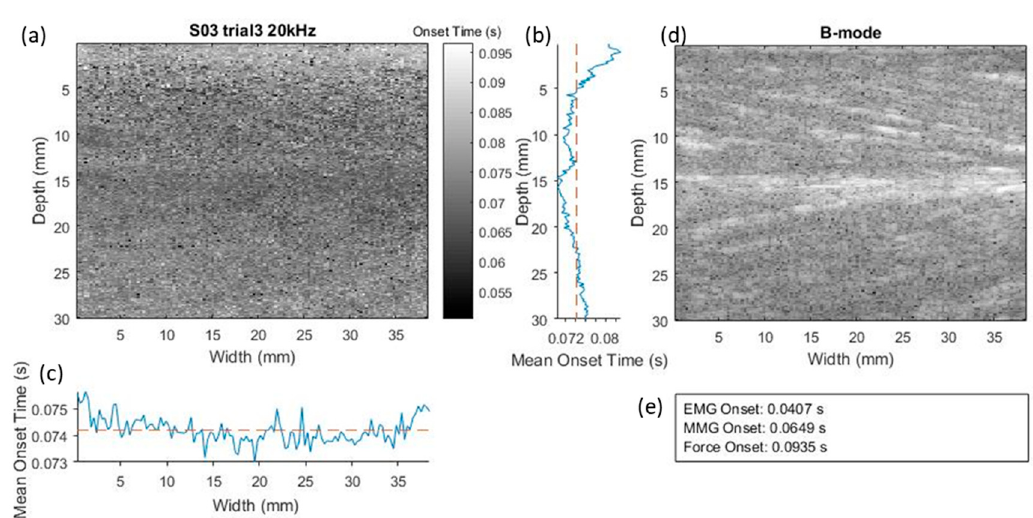
Figure 3. As example illustrating the ultrasound SMMG onset map ( a ), B-mode ultrasound image of muscle along longitudinal view ( d ) and the EMG, MMG, force onset time ( e ) recorded in a trial. In the mean onset time plots, the blue solid line represents the mean onset time measured using SMMG along the muscle depth direction ( b ) and longitudinal direction ( c ), while the orange dotted line represents the overall mean onset time measured with SMMG.